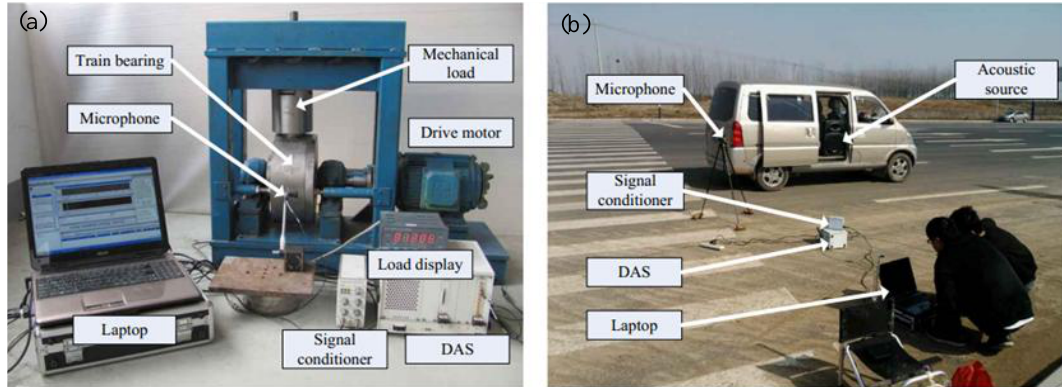
Figure 8. Experimental setup for acoustic signal acquisition with the Doppler effect: ( a ) test bench of the first experiment and ( b ) actual scene of the second experiment. (a) (b)